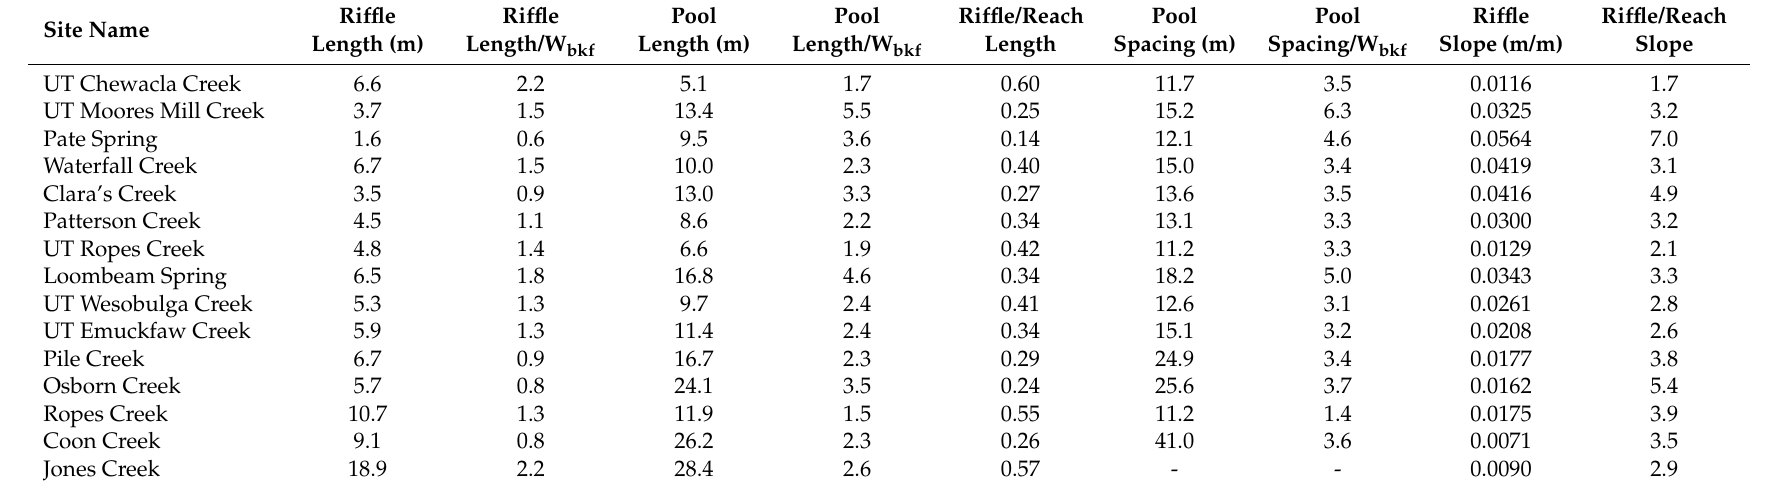
Table 2. Bedform dimensions for 15 reference streams of the Tallapoosa basin in the Piedmont of east Alabama. See text for variable